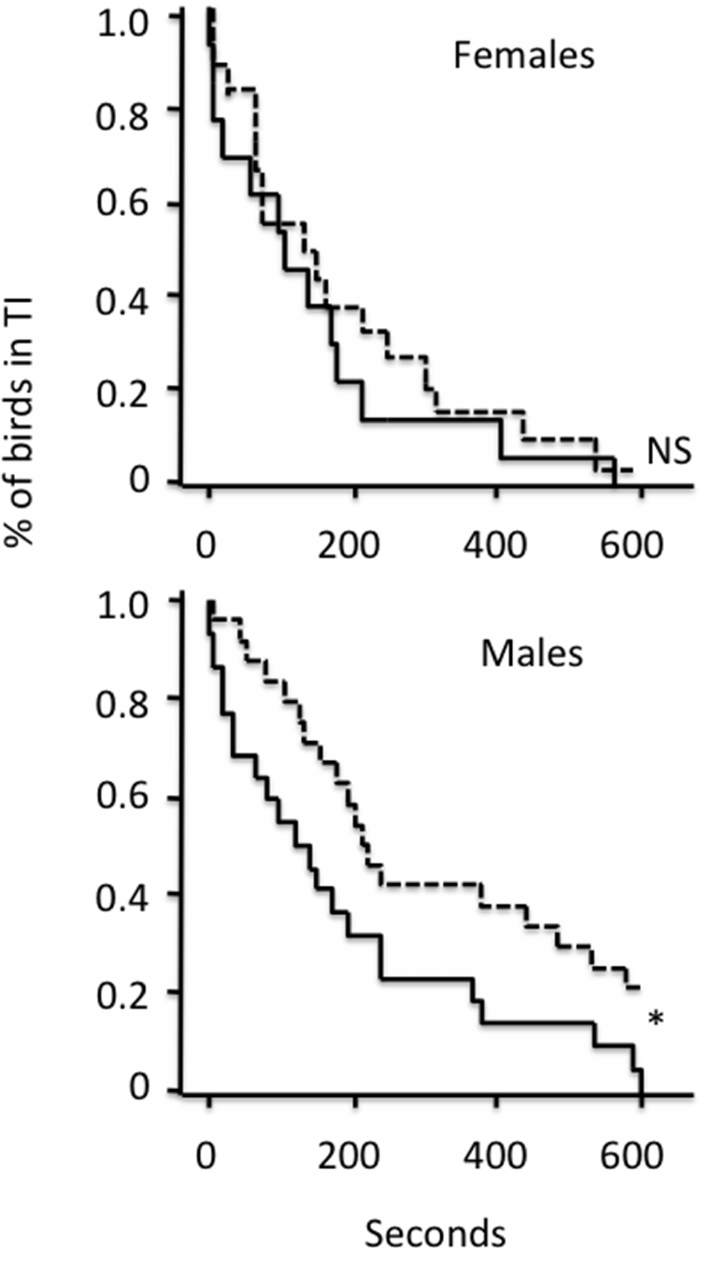
Fig 2. Survival plots for the variable “ first head movement ” in the tonic. immobility (TI) test. Females (N = 31) and males (N = 46) are shown in separate plots. Solid lines show values for early stressed birds, and dotted lines for control. The treatment effect is significant in males but not in females. * : P < 0.05, NS = not